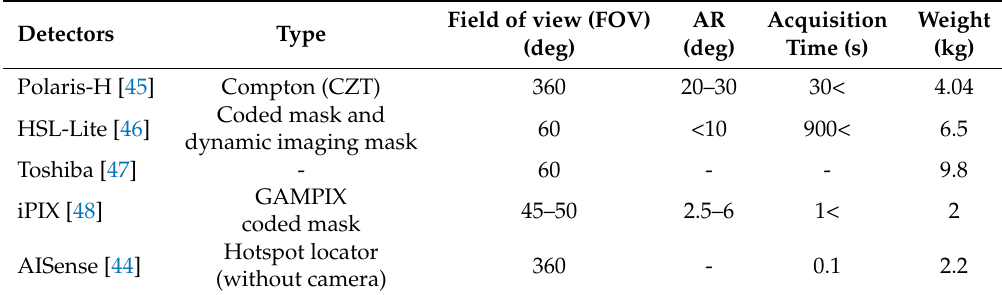
Table 1. Specifications of the selected commercial directional